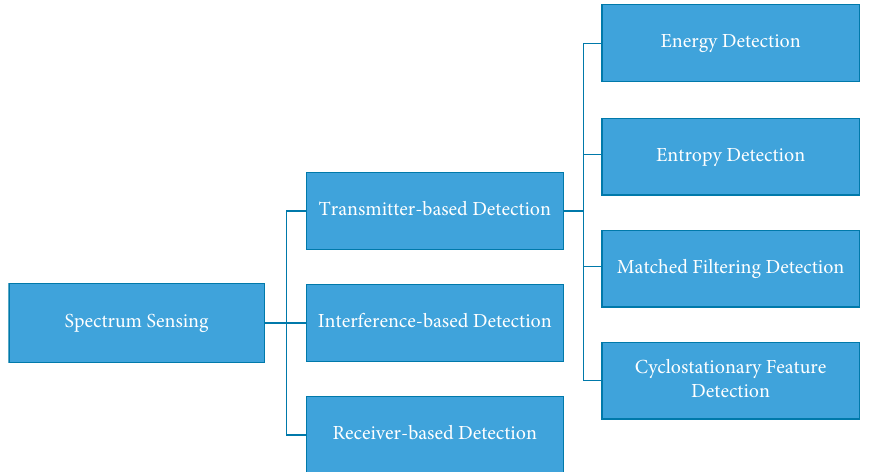
Figure 1: Spectrum sensing